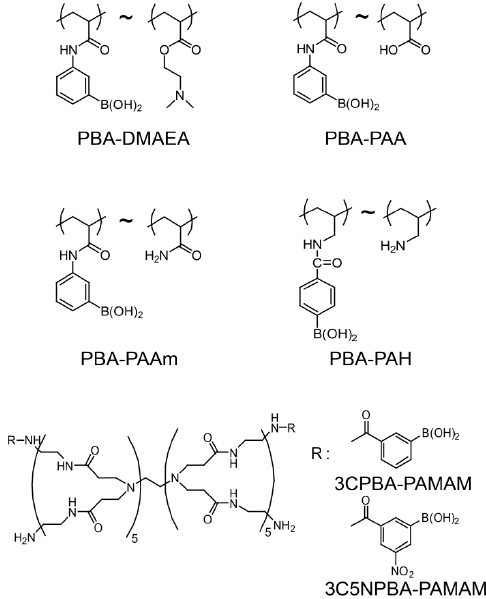
Figure 4. Chemical structures of phenylboronic acid (PBA)-modified polymers.